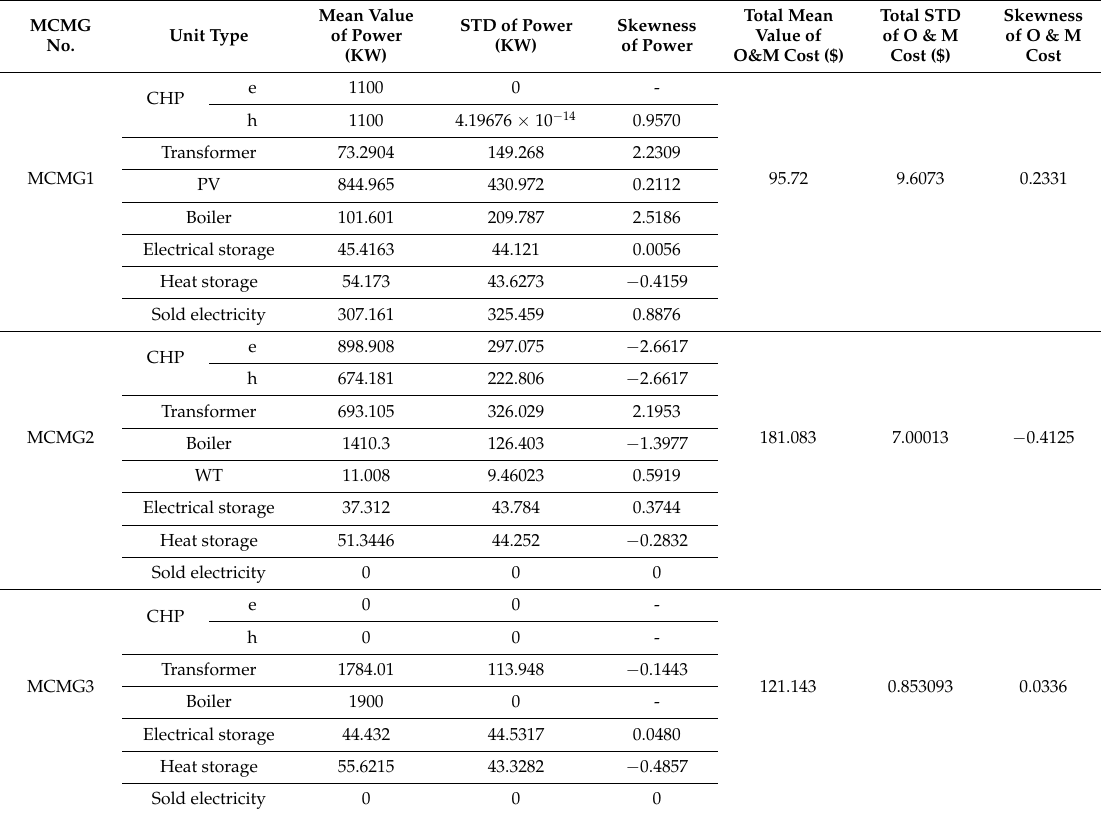
Table 3. Statistical analysis of powers and O & M costs. MCMG